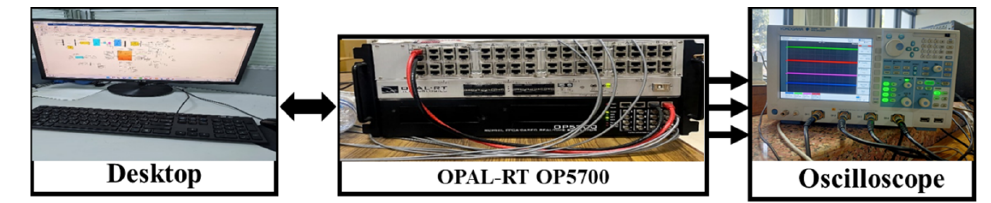
Figure 17. Experimental Steup.